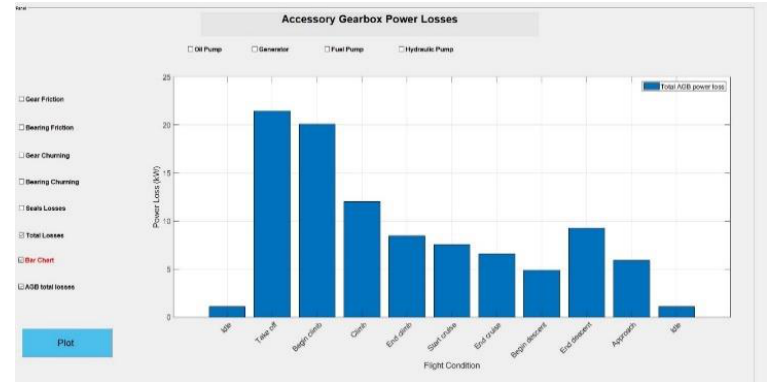
Figure 2. Accessory gearbox heat load calculation toolbox.